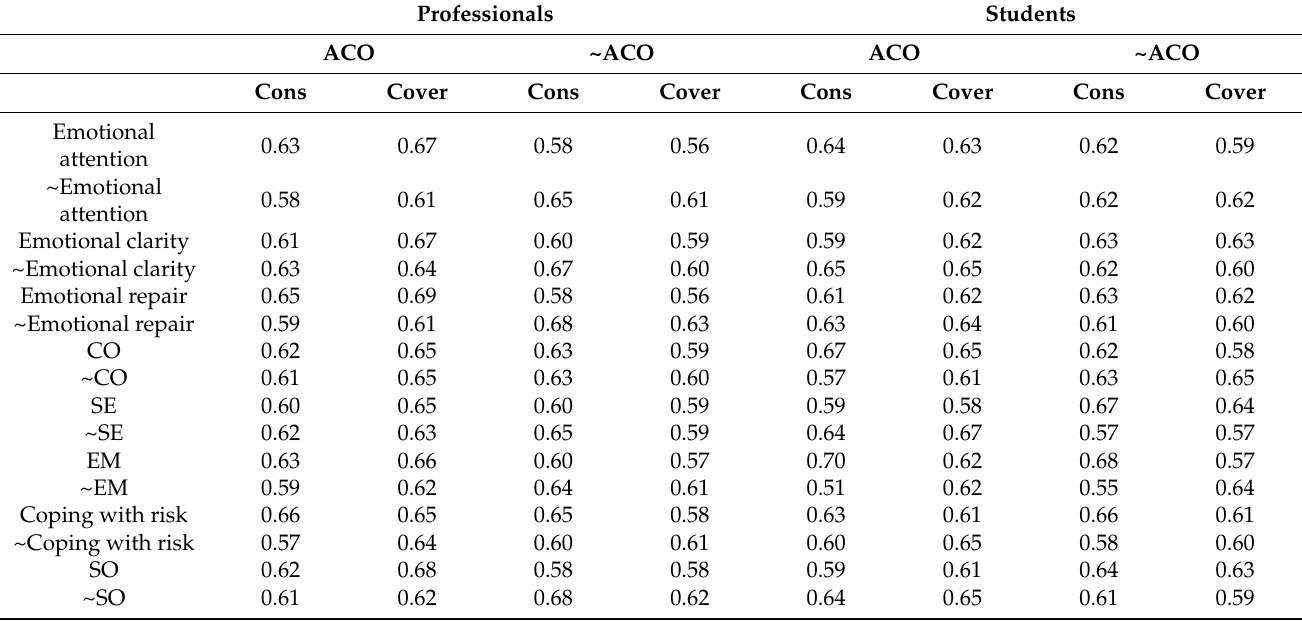
Table 4. Necessary conditions.